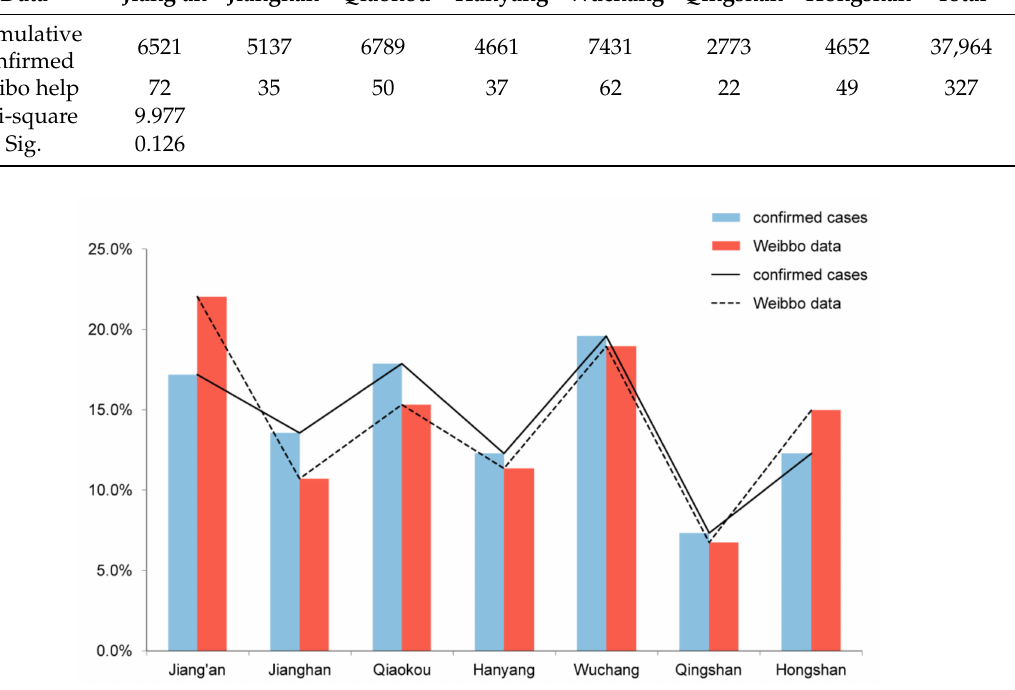
Figure 2. Comparison between the Weibo data and the confirmed